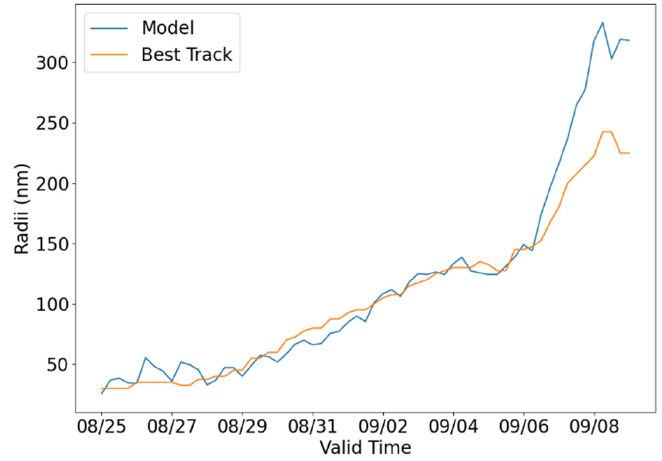
Figure 7. Hurricane Dorian (2019) 34-kt wind radii in best track (brown) and HAFS model verification (blue) by valid time.